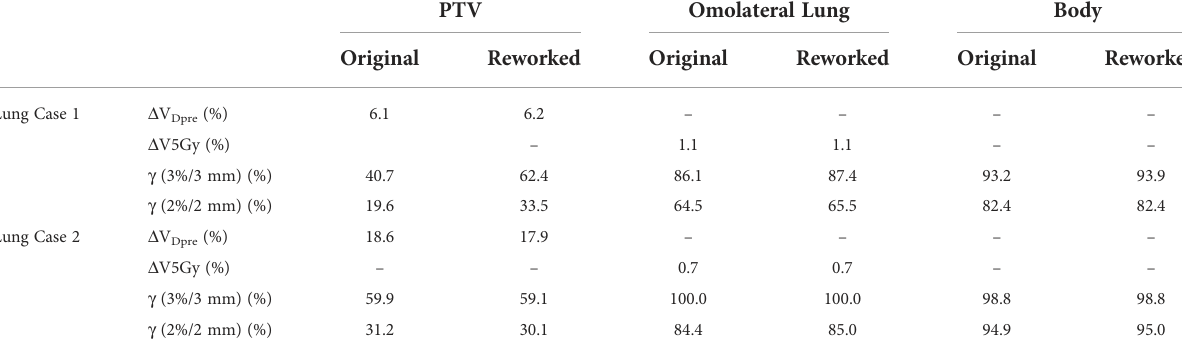
TABLE 5 Absolute difference of target and OARs DVH dosimetric parameters of the original CT and of the reworked CT vs. the corresponding syCT